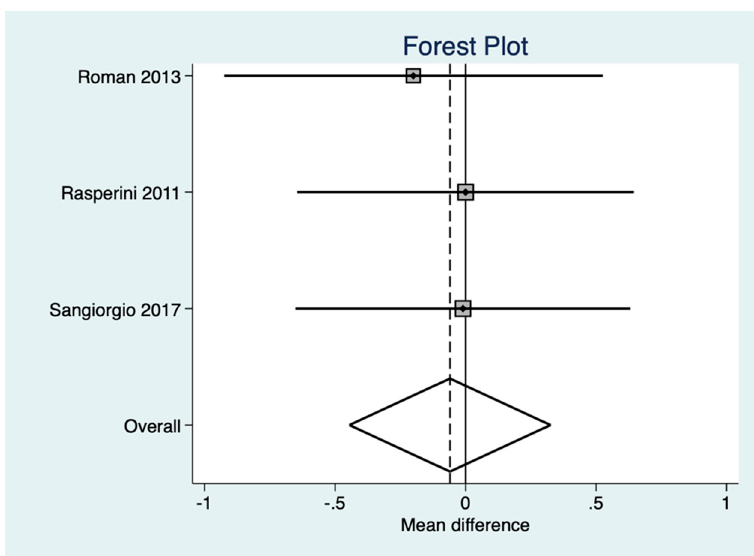
Figure 3. Forrest plot for random effect (CAF vs. CAF+EMD).